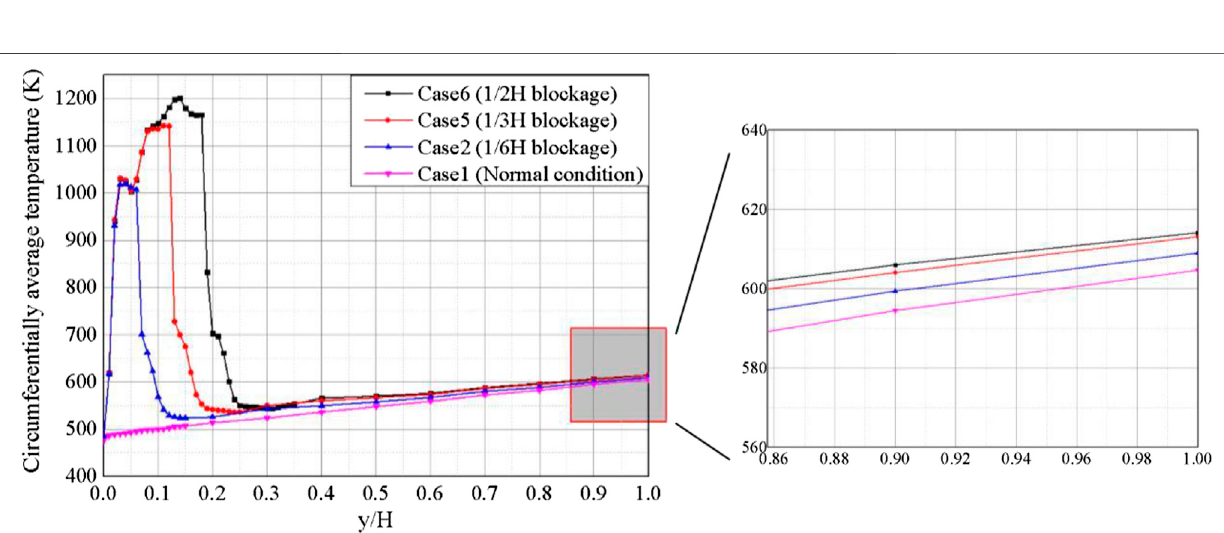
FIGURE 14 | Variations of the circumferentially averaged temperature on pin 10 along the axis direction.